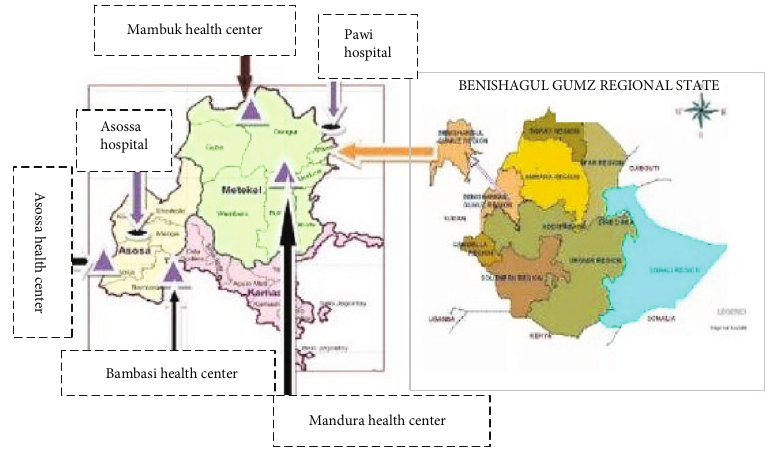
Figure 1: Sketch map of the study setting adapted from a previous study